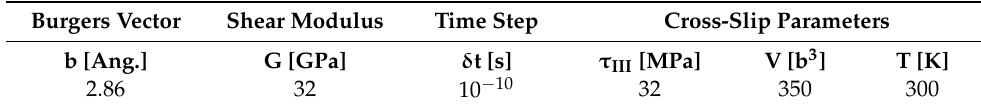
Table 2. Discrete dislocations dynamics (DDD) simulation